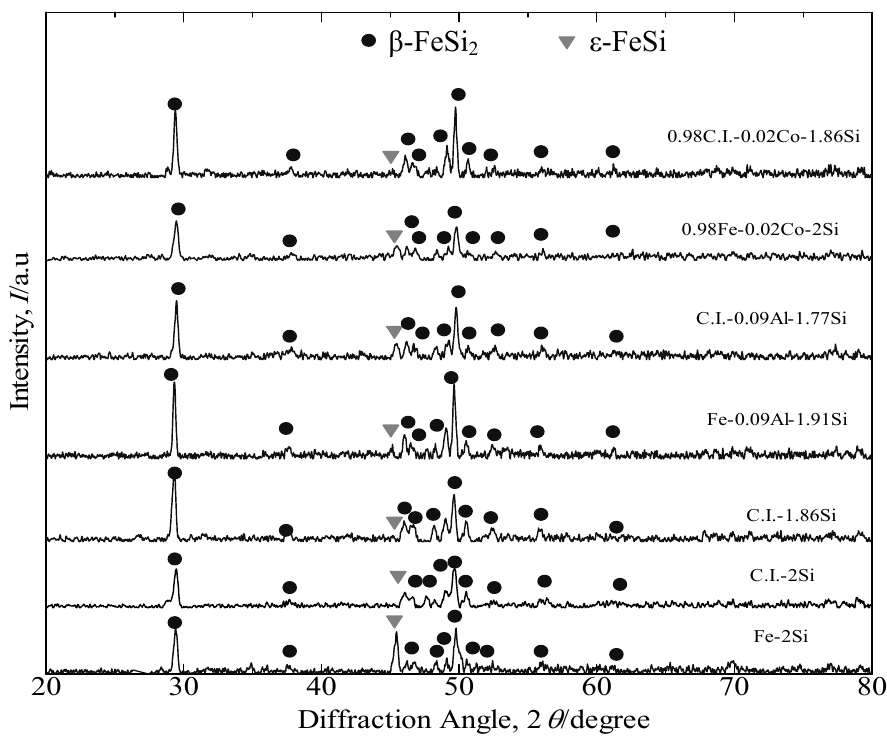
Figure 3. XRD patterns of the annealed β -FeSi cast-iron; P, pure Fe.